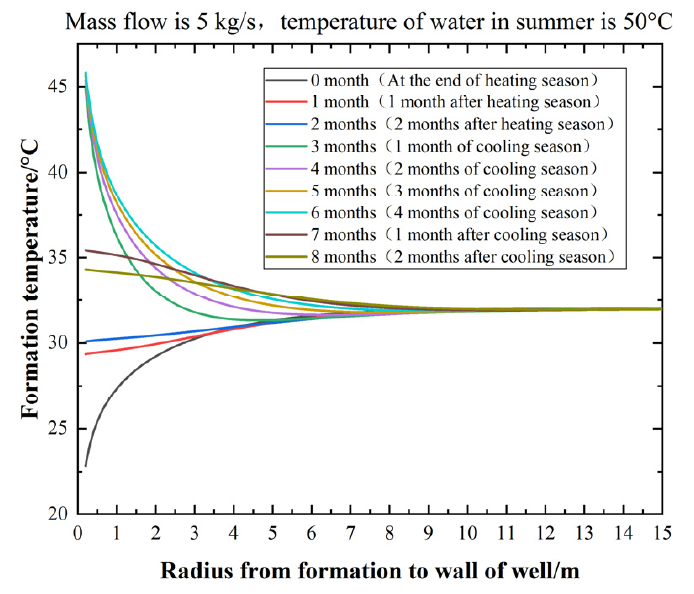
Figure 10. Radial rock temperature variation at a depth of 400 m.